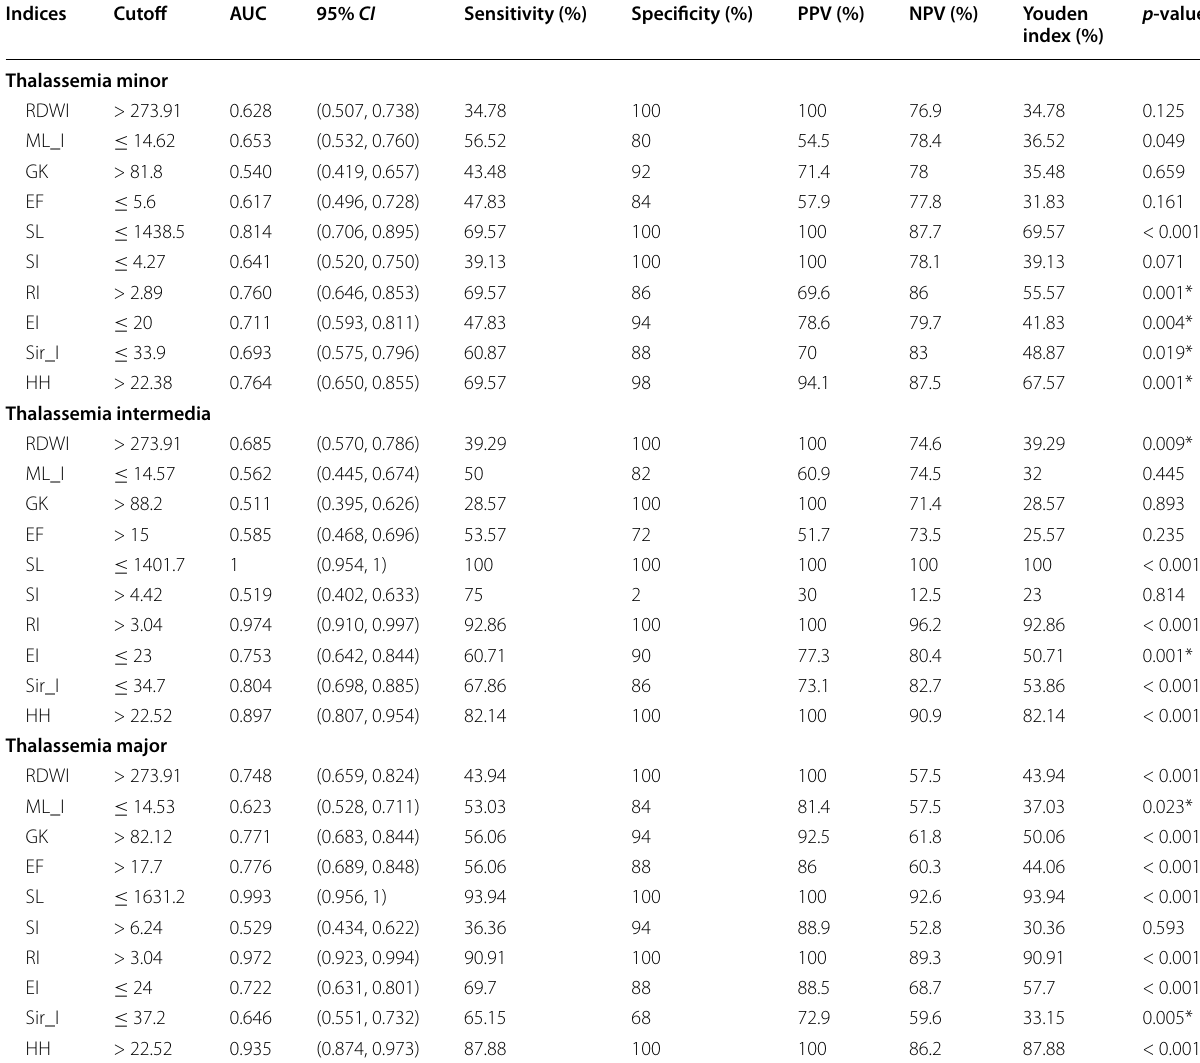
Table 4 The curve of receiver operating characteristic (ROC) of the studied indices for optimum cutoff points in diagnosing thalassemia subtypes (compared to healthy controls)